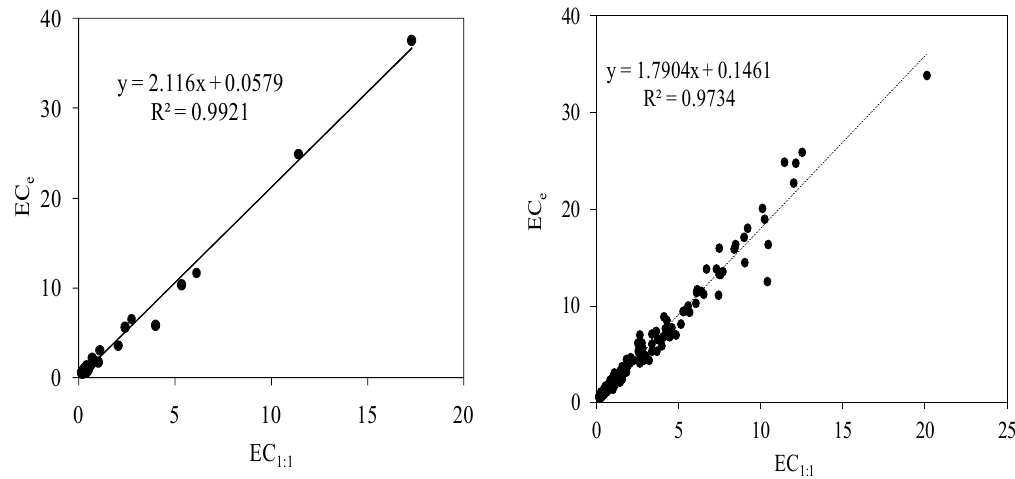
Figure 3. The EC e = f (EC 1:1 ) relationship according to the value of SP. In the left, values of SP are between 20–45% and in the right for SP >